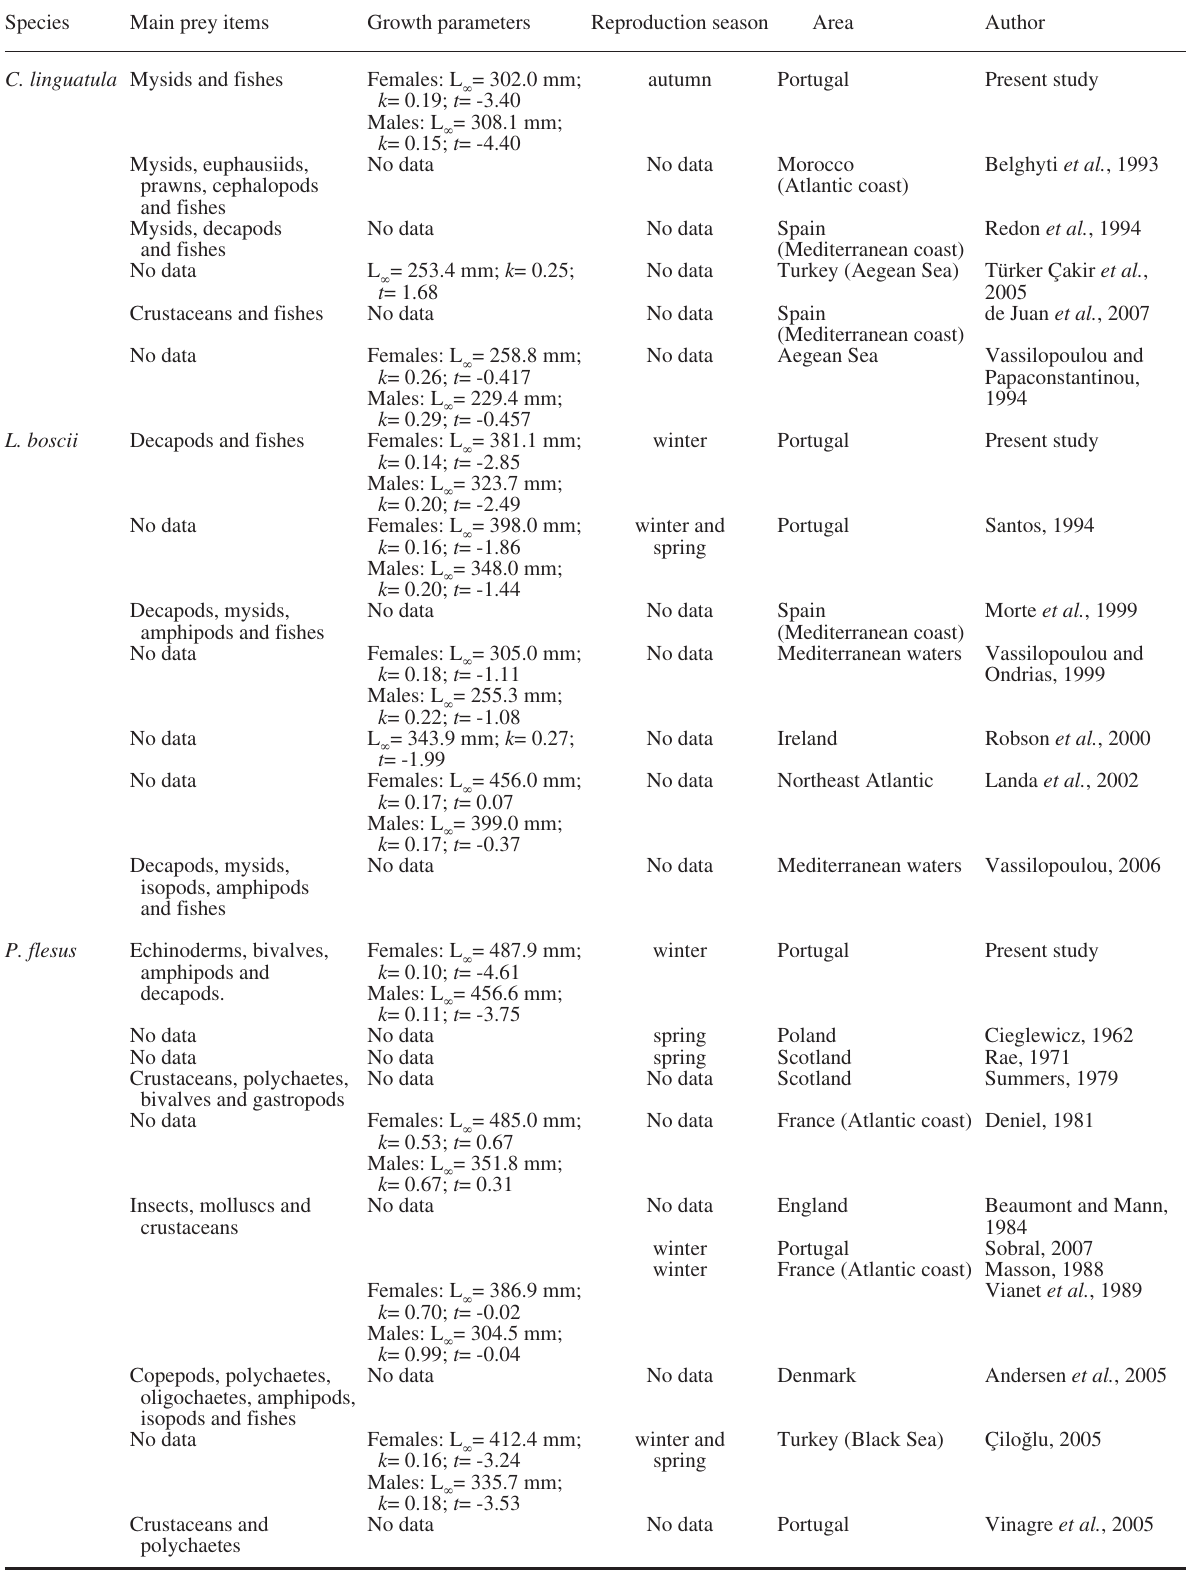
Table 3. – Summary of main prey items, growth parameters and reproduction season for Citharus linguatula , Lepidorhombus boscii , Platich- thys flesus and Microchirus azevia in different areas.